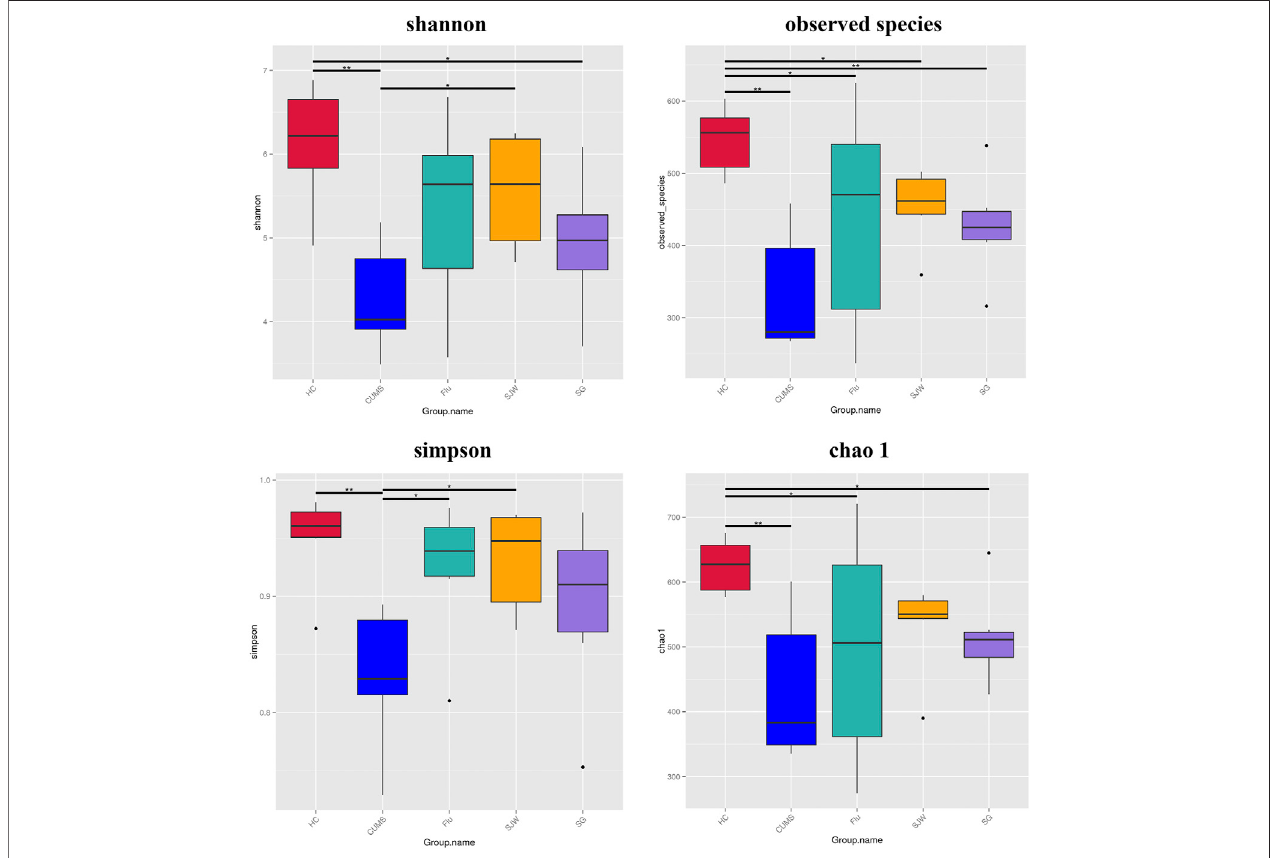
FIGURE 5 | Alpha diversity analysis index, including the chao1 index, Shannon index, Simpson index, and observed species (**** p < 0.0001; *** p < 0.001; ** p < 0.01; * p < 0.05).